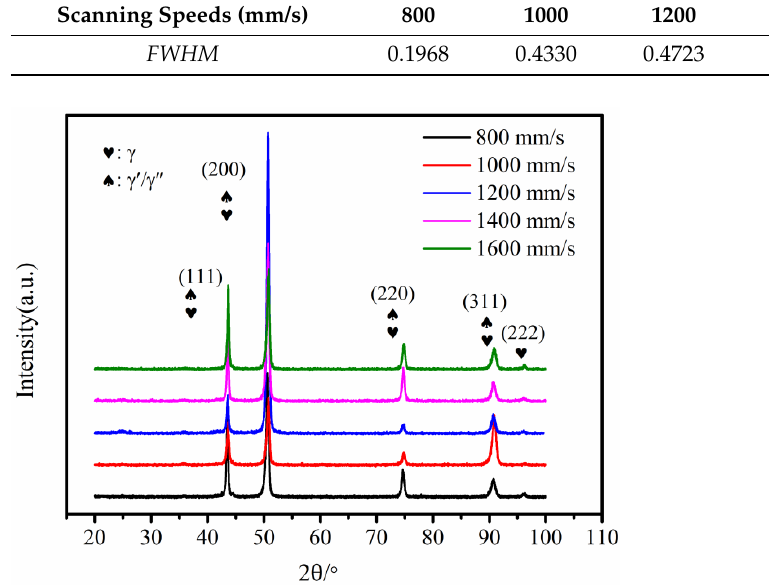
Table 2. FWHM of γ (cid:48) / γ (cid:48)(cid:48) phase diffraction peaks at different scanning speeds. Figure 2. XRD analysis of K418 samples prepared at different scanning speeds. Table 2. FWHM of γ′/γ″ phase diffraction peaks at different scanning speeds.